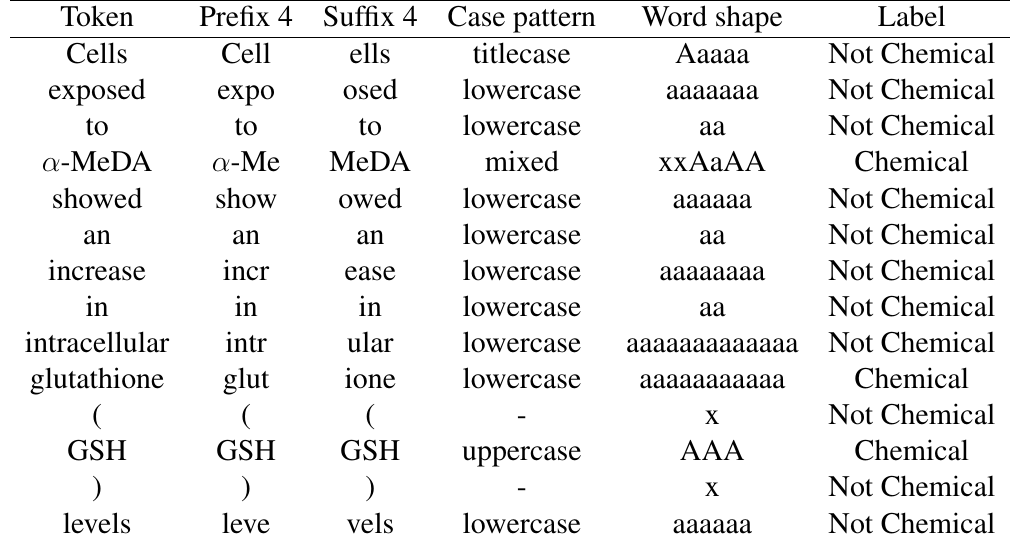
Table 2: Example of some of the new features and the corresponding label, derived from a sentence fragment (PMID